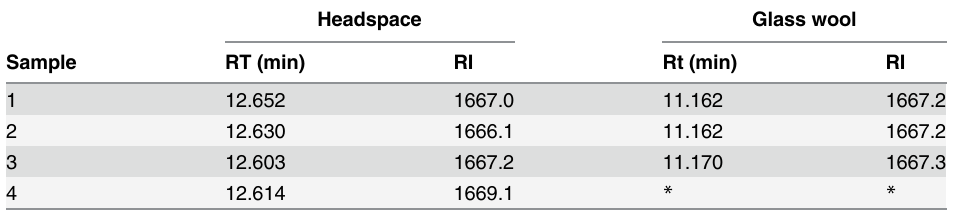
Table 4. Retention time and Kovats retention index of active compounds found in C. tristis headspace samples. Headspace